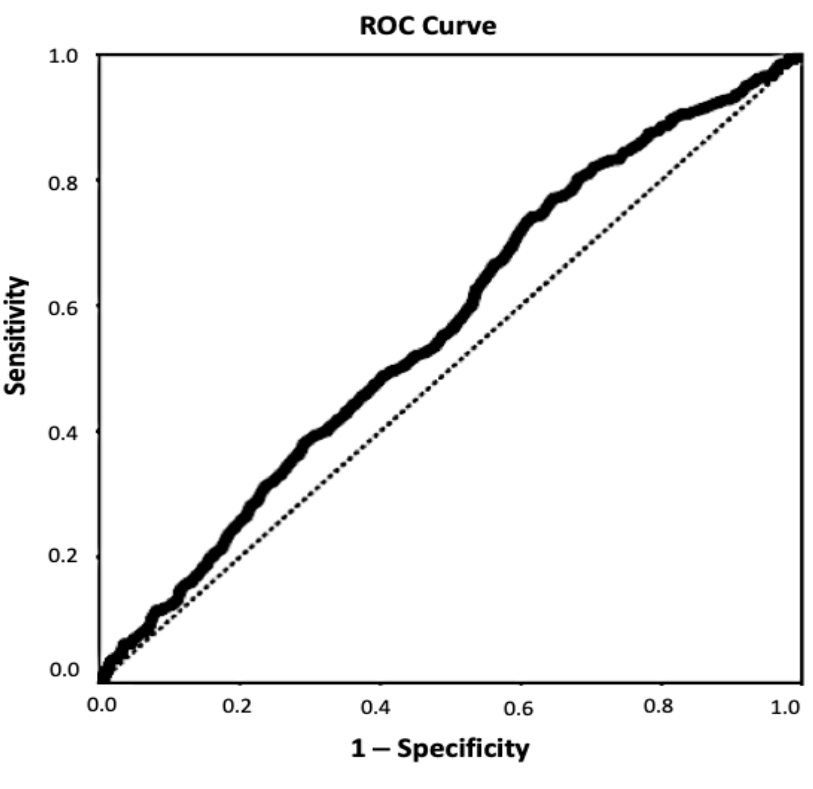
Figure 2. ROC analysis curves of hemoglobin concentration and NOAF according to anemia group. ROC, receiver operating characteristic; NOAF, new-onset atrial fibrillation.